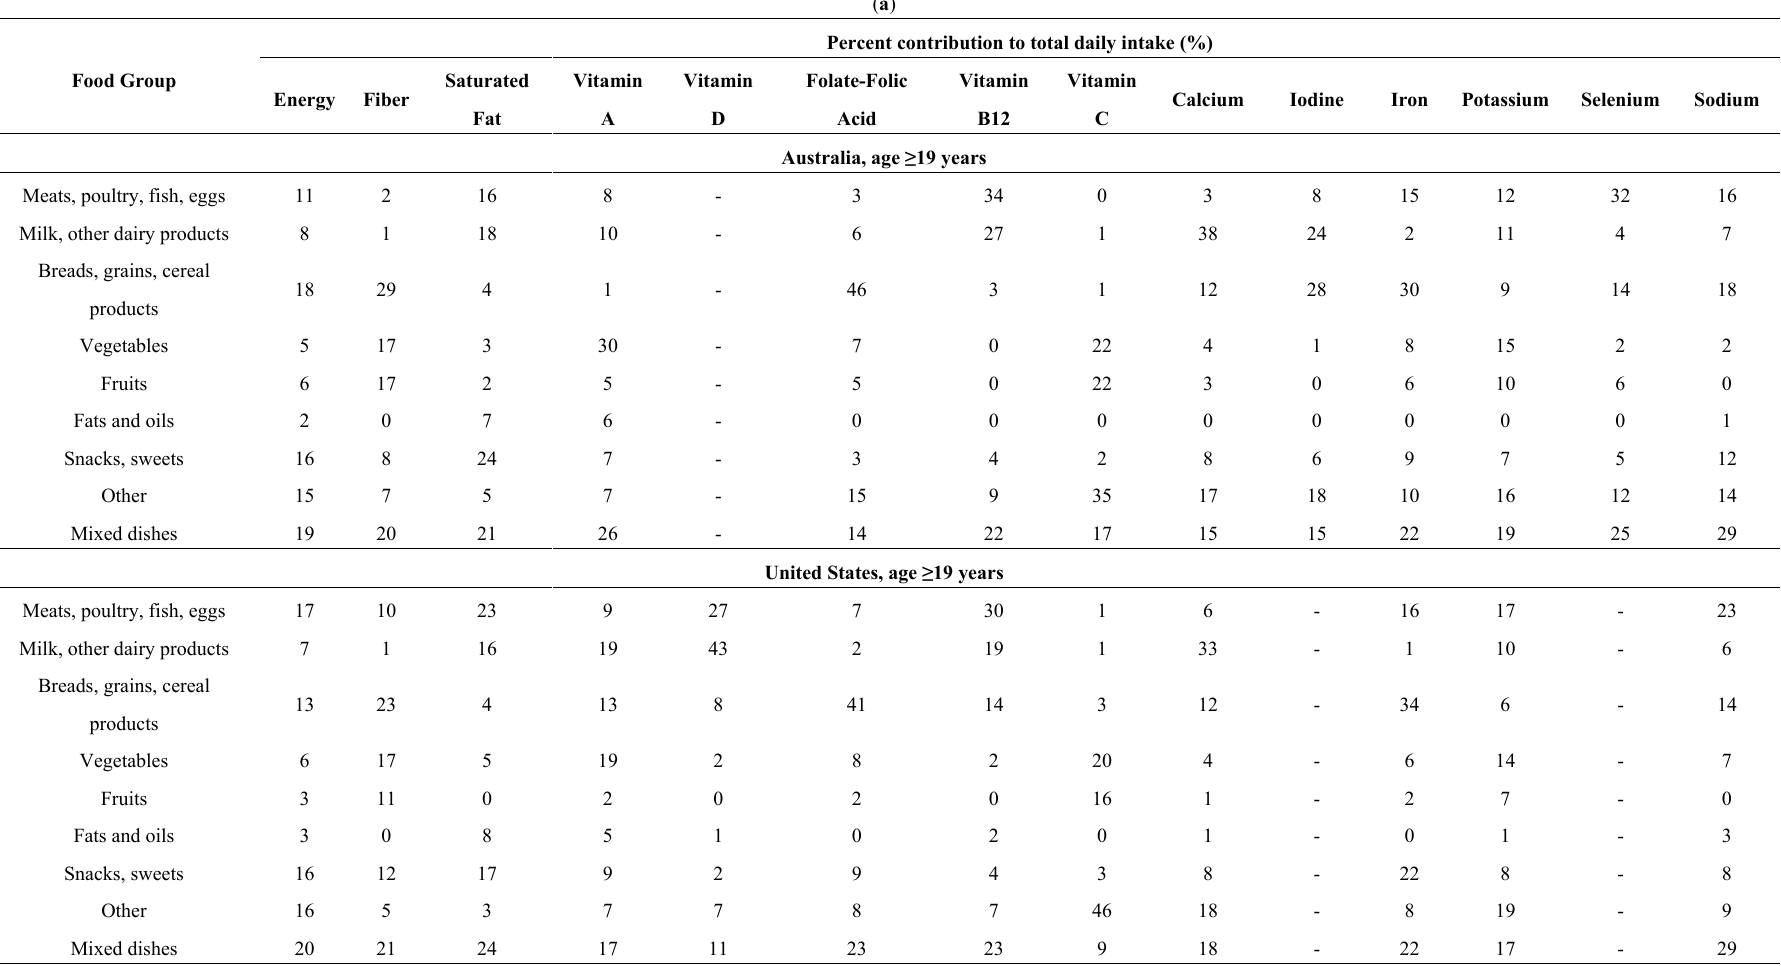
Table 5. ( a ) Contribution of foods groups and mixed dishes to total daily energy and nutrient intakes in three developed countries, adult population ; ( b ) Contribution of foods groups and mixed dishes to total daily energy and nutrient intakes in three developed countries, child